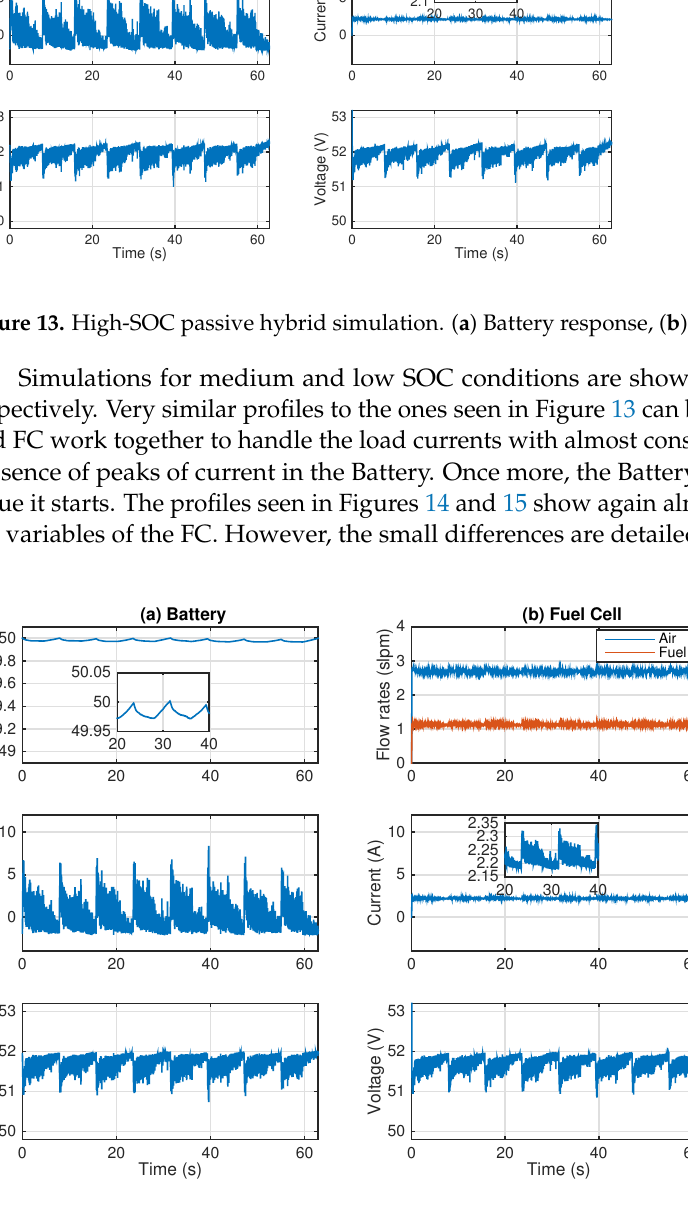
Figure 14. Medium-SOC passive hybrid simulation. ( a ) Battery response, ( b ) FC